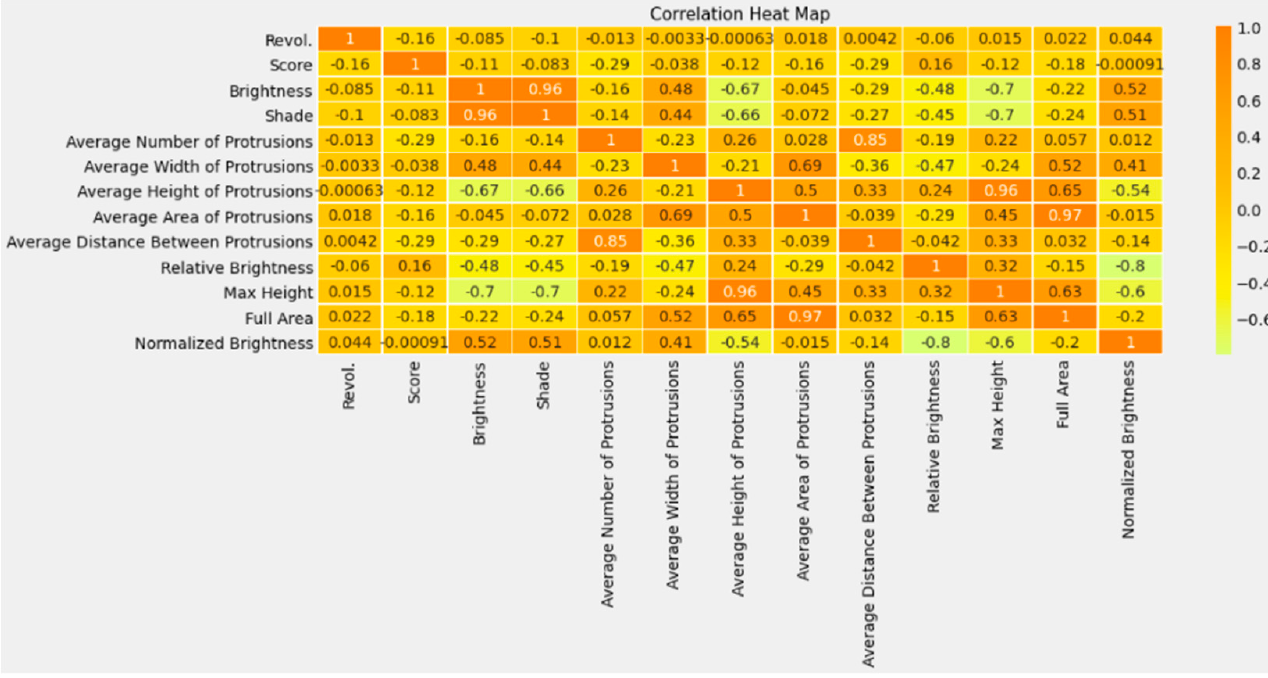
Figure 11. Full dataset correlation heat map.